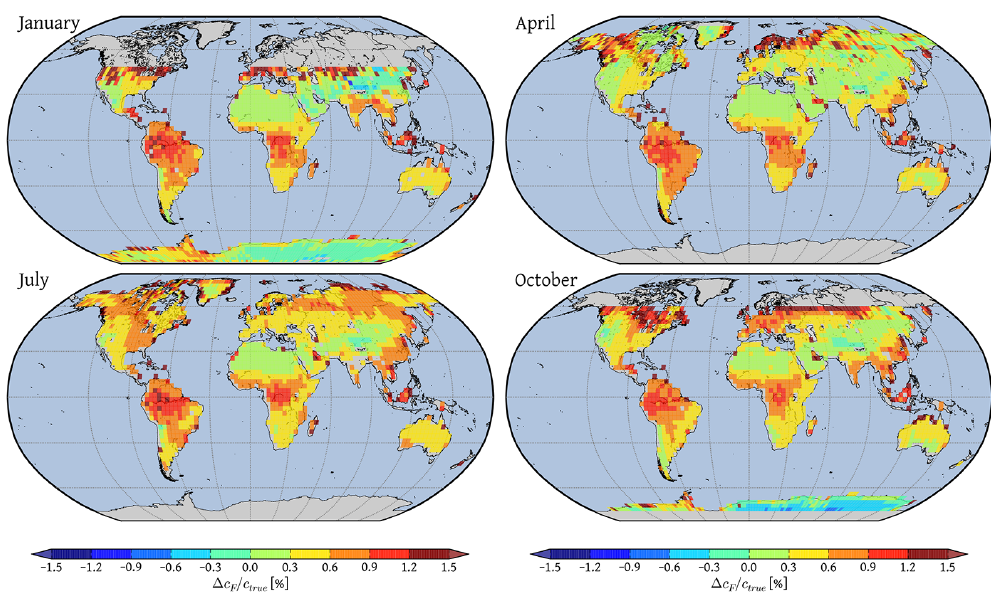
Figure 6. XCH 4 retrieval error (cid:49)c F /c true [ % ] for retrieval concept SW3 (only SWIR3 band).